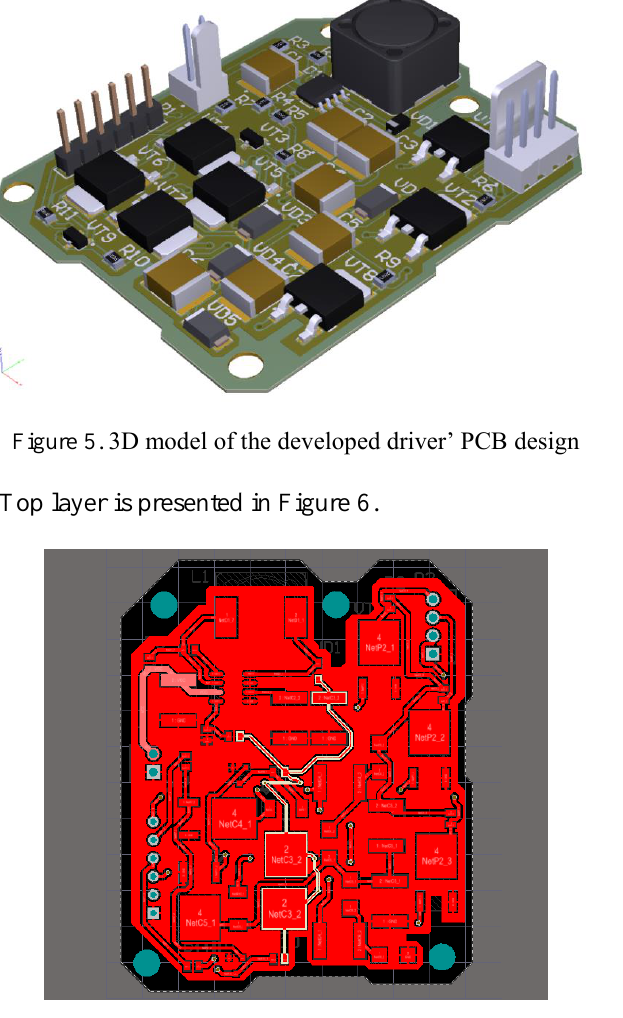
Figure 6. Topology of the PCB top